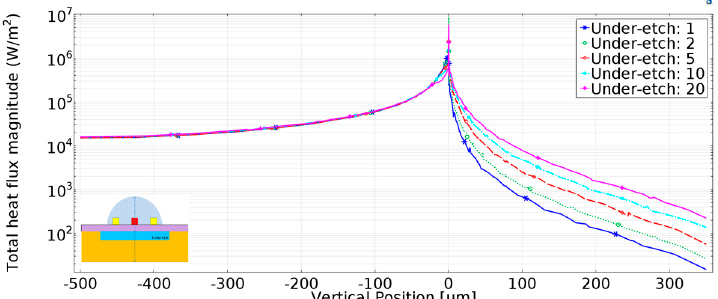
Figure 2. Heat flux into ethanol as a function of lateral position of the structure shown in the insert. The bottom of the heater is used as the vertical reference position for the y-axis. The under-etched cavity (width in μ m) is assumed to be sealed and filled with